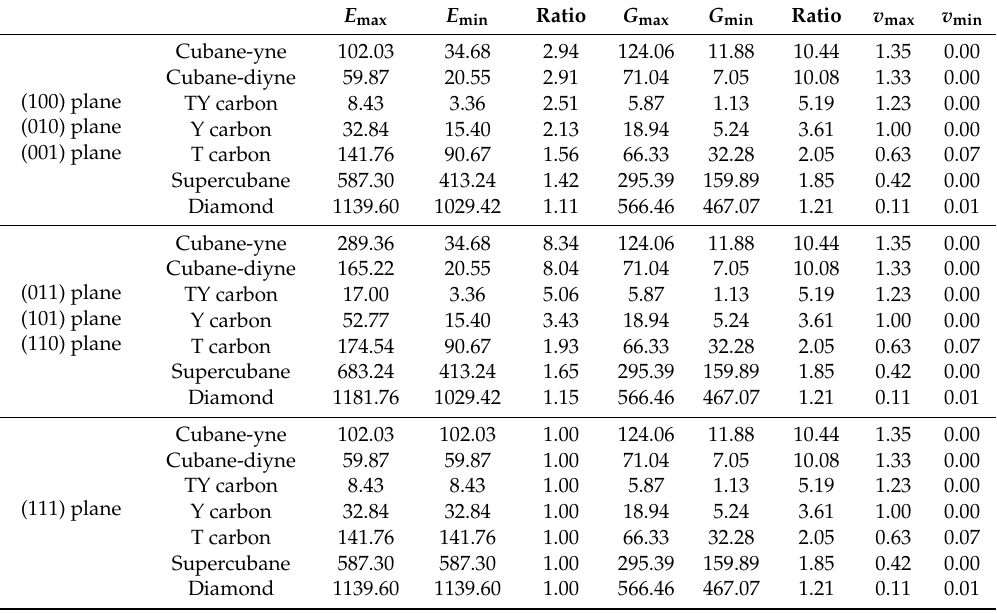
Table 2. The calculated maximum (GPa), minimum values (GPa), and X max / X min ratio ( X = G or E ) of cubane-diyne, cubane-diyne, supercubane, T carbon, TY carbon, diamond, and Y